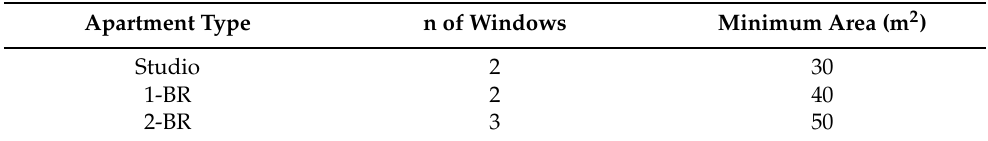
Table 1. Minimum apartment